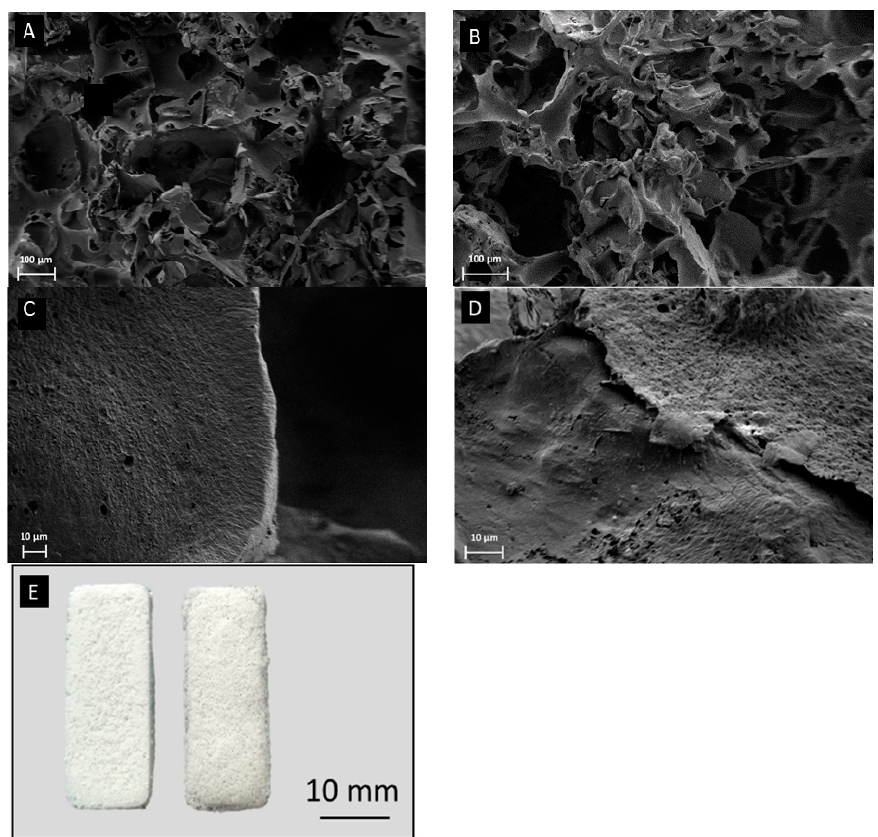
Figure 1. SEM images of neat P(3HB) scaffold ( A ), neat P(3HO) scaffolds ( B ), P(3HB)/Cu-doped bioactive glass (BG) composite ( C ), and P(3HO)/Cu-doped BG composite ( D ). ( E ) Digital camera images of P(3HB)/BG (left) and P(3HO)/BG (right) scaffolds.